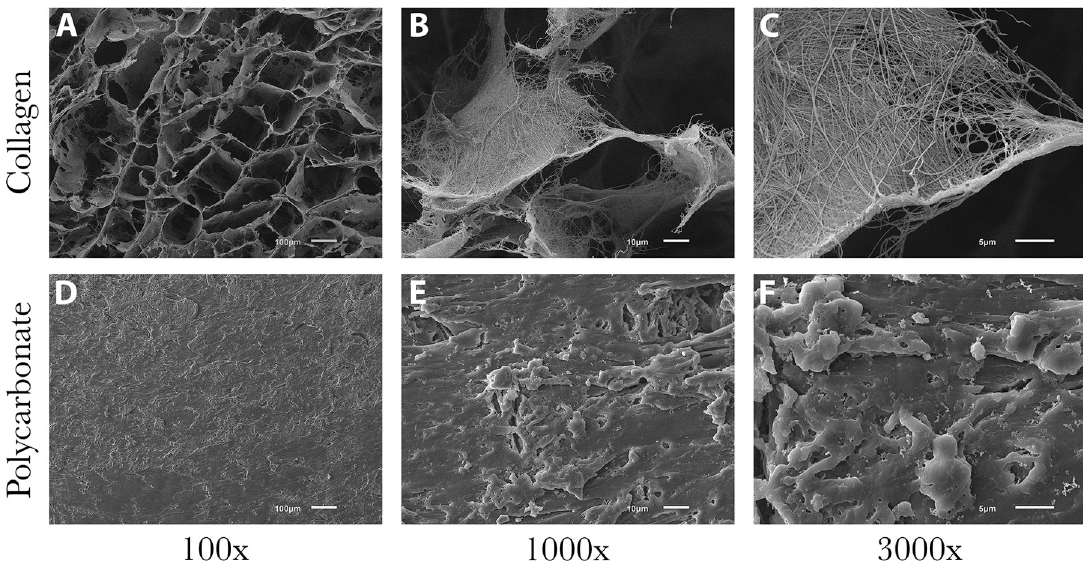
Fig 2. Representative SEM images of collagen and polycarbonate coupon surfaces. (A-C) Surface of a collagen coupon after soaking in broth only (no bacteria present). Deep valleys and ravines were consistent throughout the amorphous structure. (D-F) Surface of a polycarbonate coupon after soaking in broth only (no bacteria present). Ridges and plateaus had an undulating, yet mostly smooth surface, in particular relative to collagen.